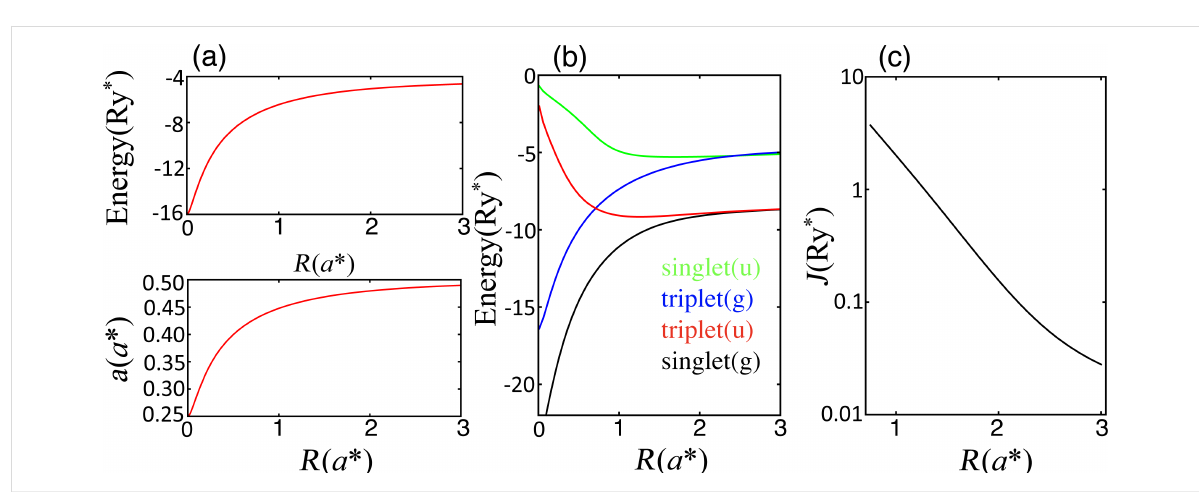
Figure 2: (a) Bohr radii and energy for one electron bound to a donor pair as a function of R . For R = 2 a * , = − 5.06 Ry * and = 0.48 a * . Assuming ε = 5 and using the effective masses shown in Table 1, = 6.8 Å and = − 515 meV, = 7.6 Å and = − 460 meV, = 10 Å and = − 350 meV, = 1.96 Å and = − 1.77 eV. Using m eff and ε for MoS 2 and h-BN in Table 1, we obtain = 2.2–2.7 Å and = − 1.59 eV, and = 0.5 Å and = − 15 eV. (b) Energies for two electrons bound to a donor pair as a function of the inter-donor distance R , see Supporting Information File 1 for the definition of the wave function. (c) Exchange J in effective units as a function of the separation between donors. For R = 2 a * , J = 0.156 Ry * . For this distance, assuming ε = 5 and using the effective masses in Table 1, J ZnS = 16 meV, J CdS = 14 meV, J CdSe = 11 meV, J SiC = 55 meV. Using m eff and ε for MoS 2 and h-BN in Table 1, we get = 50–60 meV and J h − BN = 467 meV.